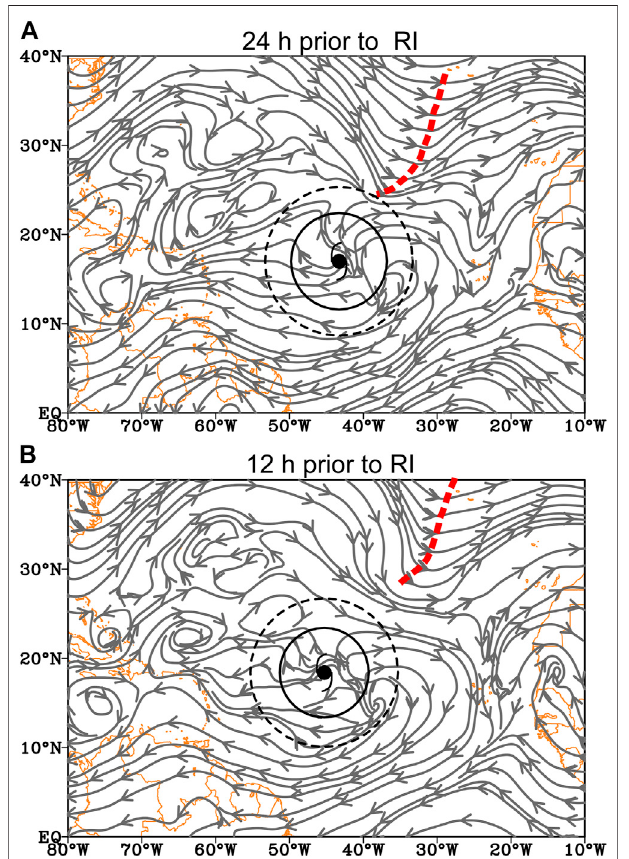
FIGURE 11 | Streamline at 200 hPa for the total fi eld after removing the TC vortex (A) 24 h and (B) 12 h prior to RI. The black solid circle indicates the radius of the outer closed isobar (ROCI) of 650 and 600 km for (A) and (B) , respectively. The black dashed circle denotes R (cid:2) 1,000 km. The red dashed lines denote the westerly trough.